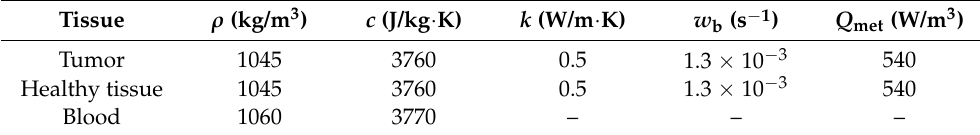
Table 2. Physical properties of the tissues [36,63,67,71,94]. Tissue ρ (kg/m 3 ) Tumor 1045 Healthy tissue 1045